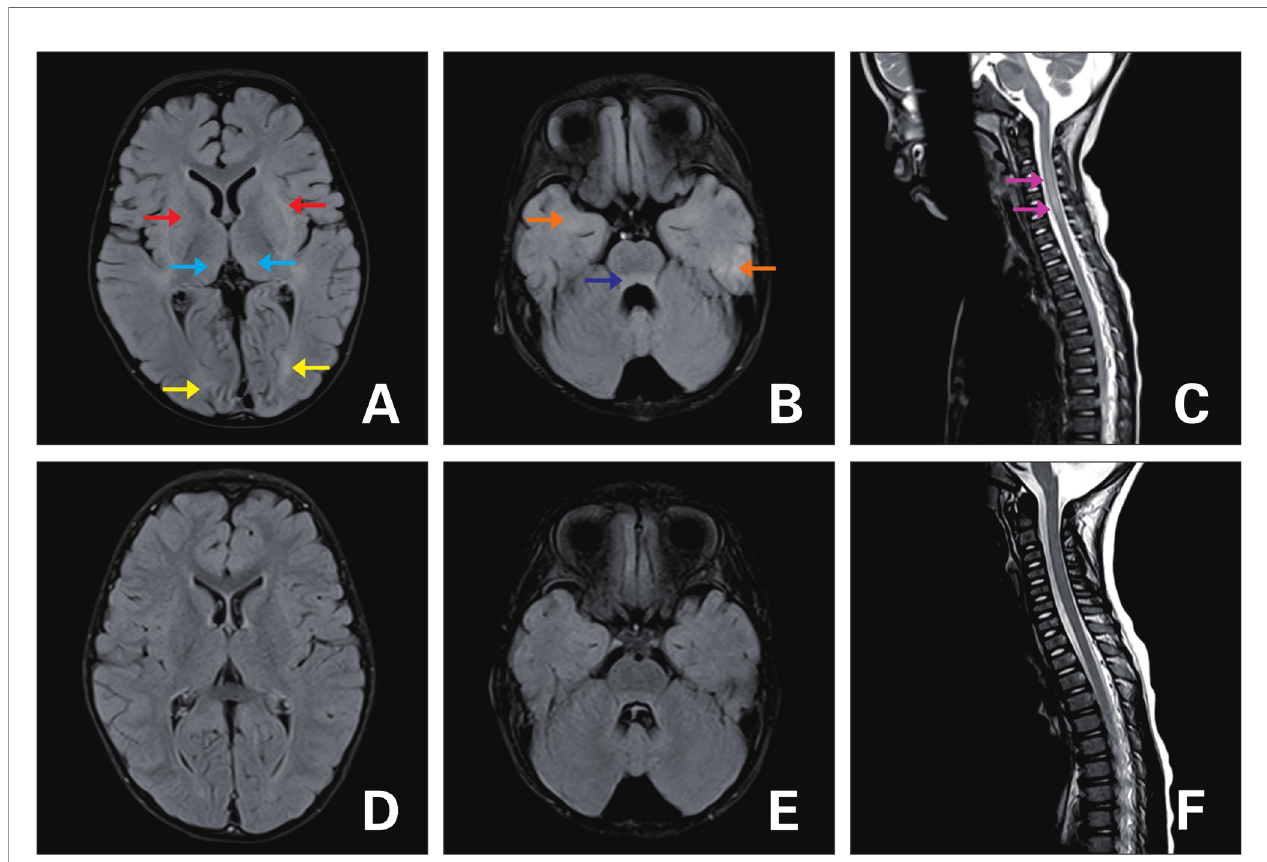
FIGURE 3 | FLAIR MRI of the brain (A – C) upon admission and (D – F) 3 months later. (A, B) T2-hyperintense lesions in the dorsal thalamus (blue arrow), basal ganglia (red arrow), bilateral cerebral hemispheres (yellow arrow:occipital lobe;orange arrow:temporal lobe), and pontine (dark blue arrow). (C) Lesions in the cervical spinal cord (purple arrow). (D – F) Follow-up images of T2 lesions after they